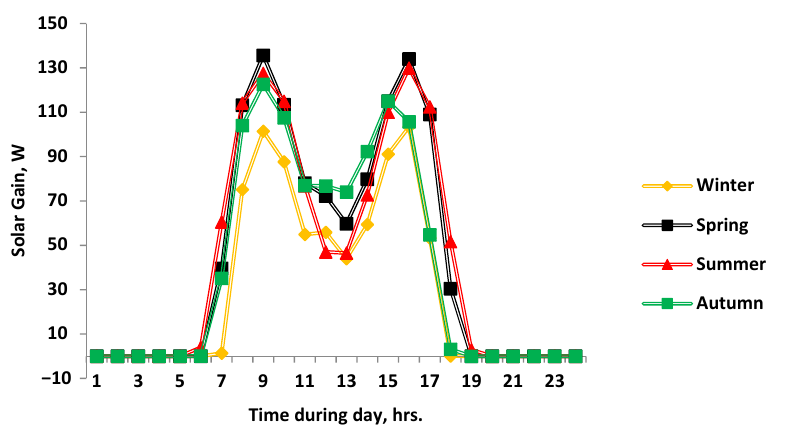
Figure 10. Solar heat gain (SHG) in the underground room in all seasons. Table 2. Inner surface of the UG using a thermal imaging camera in different orientations.